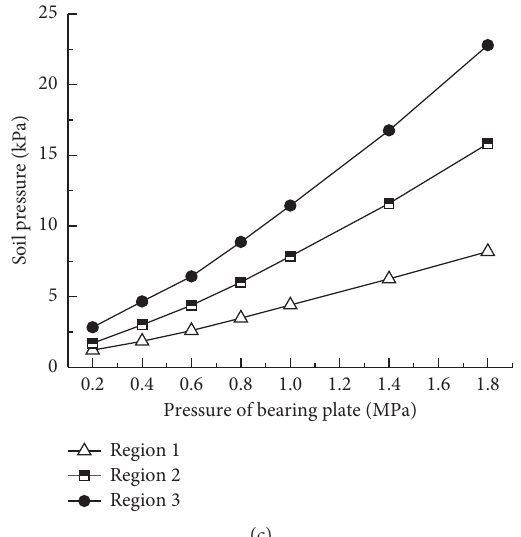
Figure 15: The change of soil pressure with pressure of bearing plate: (a) first layer constructed; (b) second layer constructed; (c) third layer constructed.